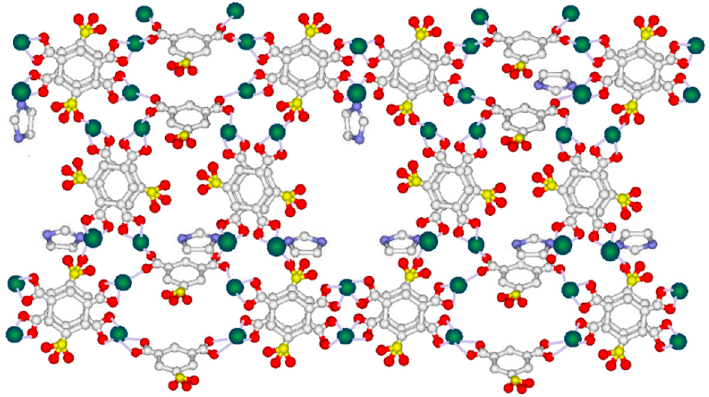
Figure 8. Schematic representation of coordination involving the ligands 5-sulfoisophthanic acid and imidazole for SPA-Imd-TinPCP; tin (IV); imidazole; and 5-sulfoisophthanic acid.